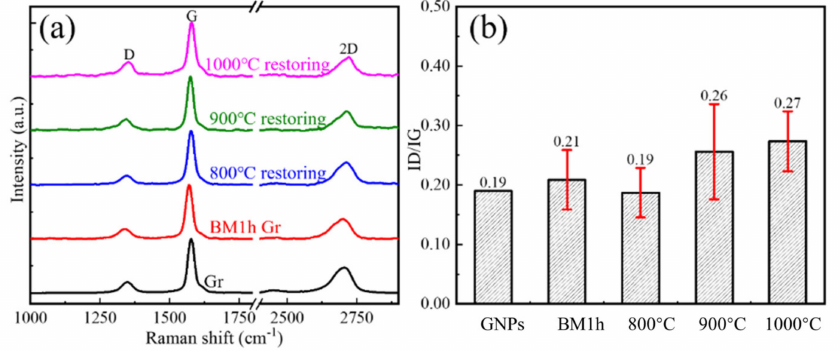
Figure 9. The Raman spectrum and I D / I G statistics of BM1h GNPs repaired at different temperatures in CVD process. ( a ) Raman spectrum, ( b ) I D / I G statistics.